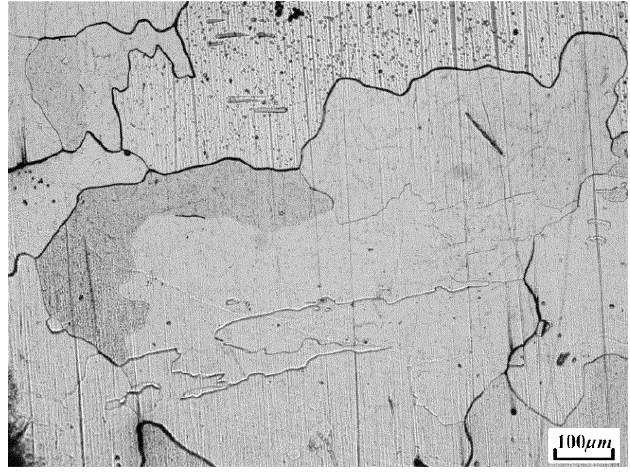
Figure 3. Microstructure of the IF steel after thermal experiment.